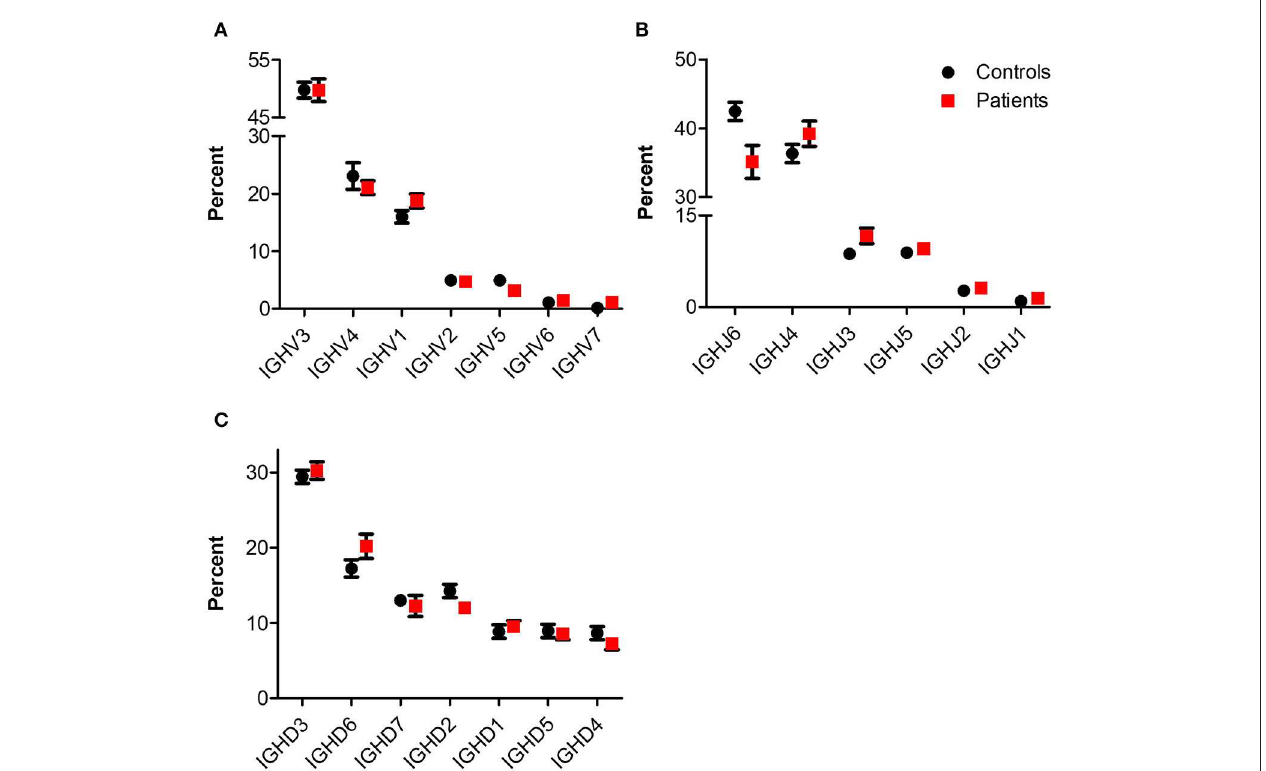
FIGURE 4 | IgH gene usage in patients with IL10/IL10R defects. Comparison of usage of (A) IGHV , (B) IGHJ, and (C) IGHD genes between control and patient groups.